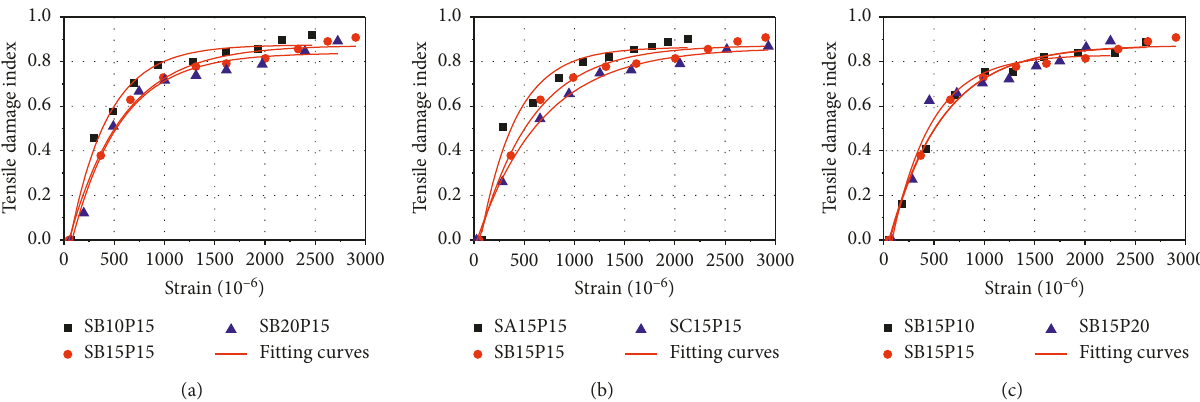
Figure 13: Damage evolution laws of SFRC under cyclic tension: (a) effect of fiber volume fraction of SF; (b) effect of fiber aspect ratio of SF; (c) effect of fiber volume fraction of PF.